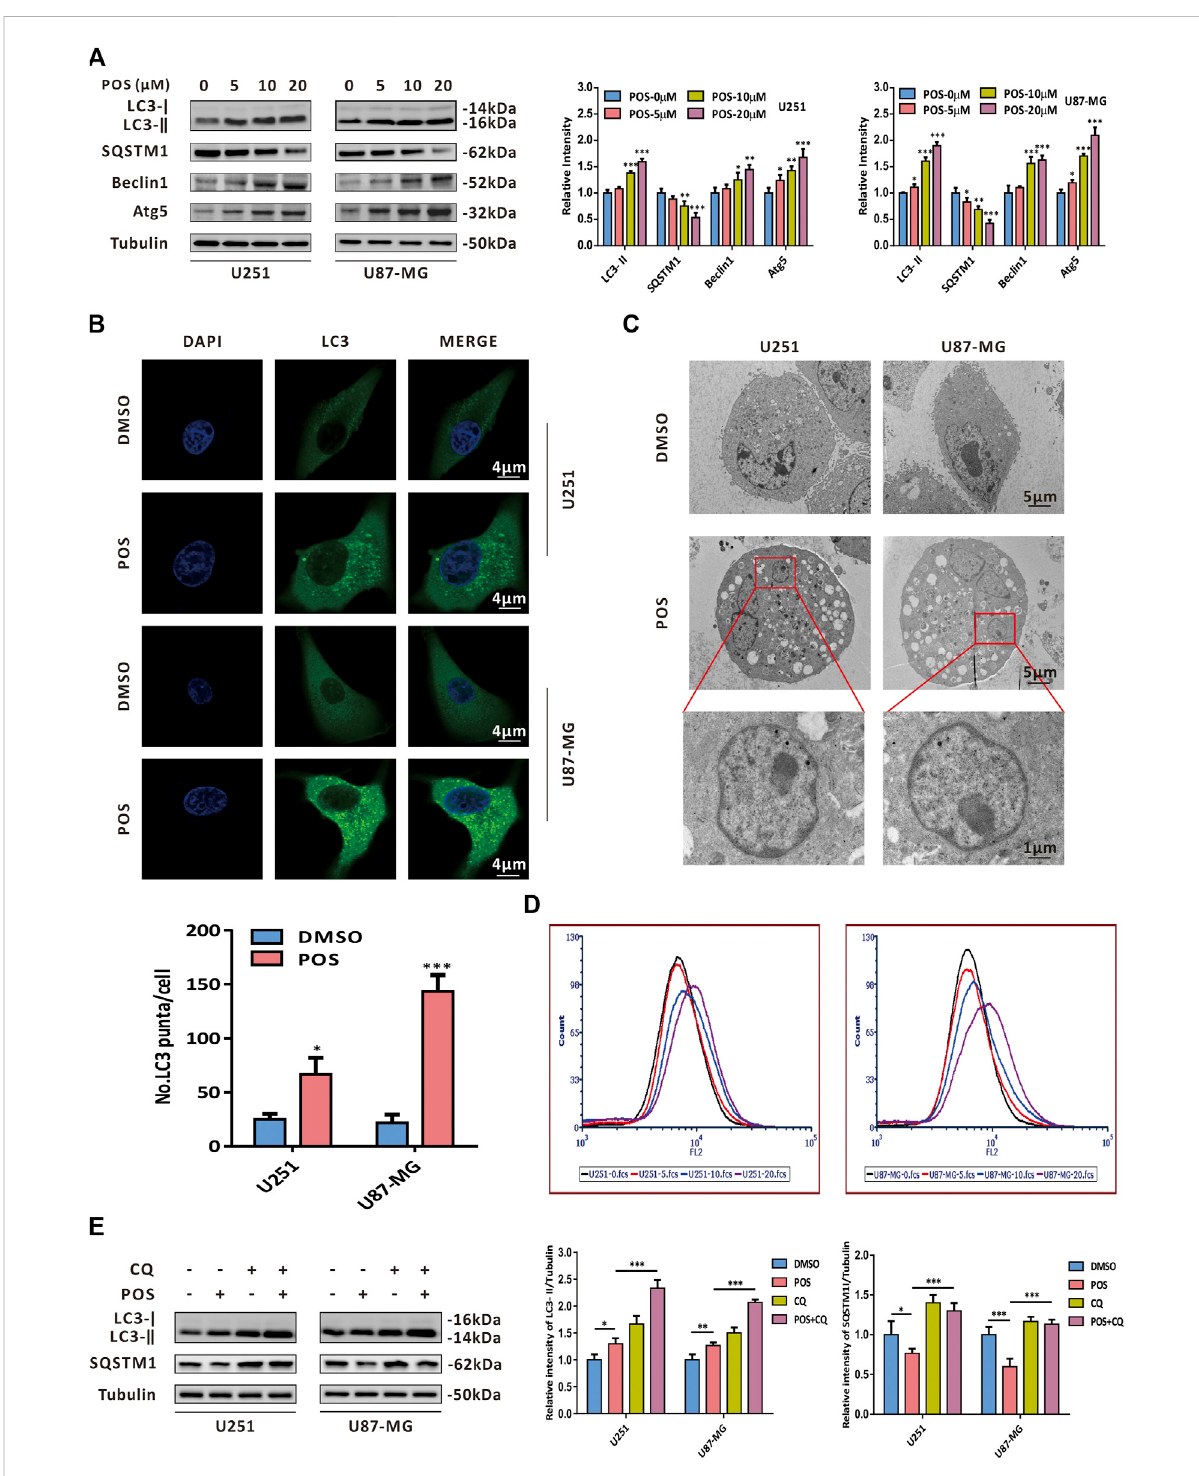
FIGURE 3 POSprovokesautophagyinGBMcells. (A) ExpressionlevelsoftheautophagymarkerproteinsLC3,SQSTM1,Beclin1andAtg5weredetectedby westernblottingafterthecellsweretreatedasindicatedfor24 h. (B) EndogenousLC3punctawereobservedbyimmuno fl uorescenceafter thecells were handled as in (A) . Scale bar, 4 μ M. (C) Autophagosomes/autolysosomes were observed by transmission electron microscopy after the cells were handled as in (A) . Scale bar: the upper and middle, 5 μ M; the lower, 1 μ M. (D) Formation of AVOs was tested by AO staining after the cells were treated as in (A) . (E) Expression levels of LC3 and SQSTM1 were detected bywesternblotting after thecells were treated with or without POS in the presence or absence of